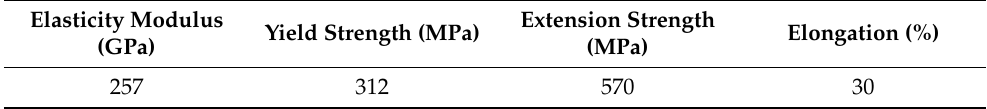
Table 3. Physical parameters of 20G steel after heat treatment at 450 ◦ C.